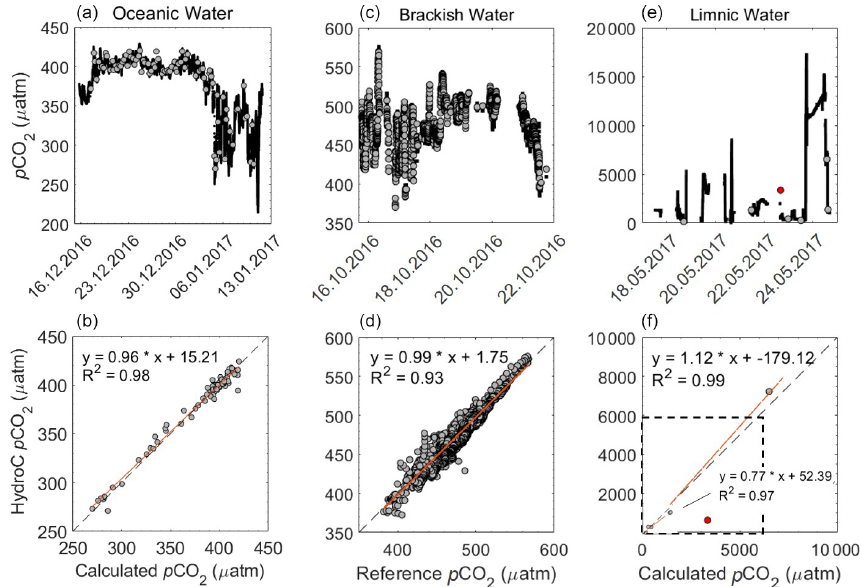
Figure 7. p CO 2 (µatm) from the HC–CO 2 within the following three regions: oceanic ( a and b , including the open ocean and the Patagonian Shelf), brackish (c, d) and limnic waters (e, f) with the reference data used. The top graphs show the overall transects, with HC–CO 2 data as a black line and the reference data as grey dots (date presented as dd.mm.yyyy). The lower graphs are property–property plots showing the 1 : 1 line (dashed) and the line of the best linear fit (orange). For the validation of our system, we used the calculated p CO 2 from TA and DIC, using CO 2 SYS for both oceanic and limnic waters, whereas a reference system was used for the brackish waters, as described above. During the Rom1 (limnic cruise), n = 7 with the outlier in red (sample with an unclear match to flow-through data excluded from fit), with the box (dashed line) indicating the 6000ppm company calibration limit.